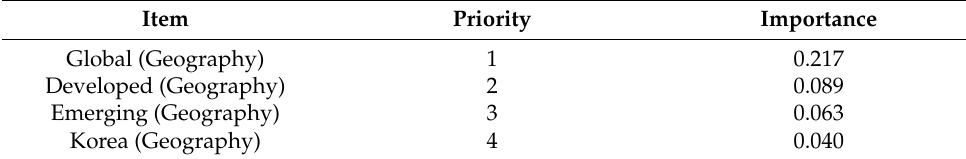
Table 10. Results of targeted